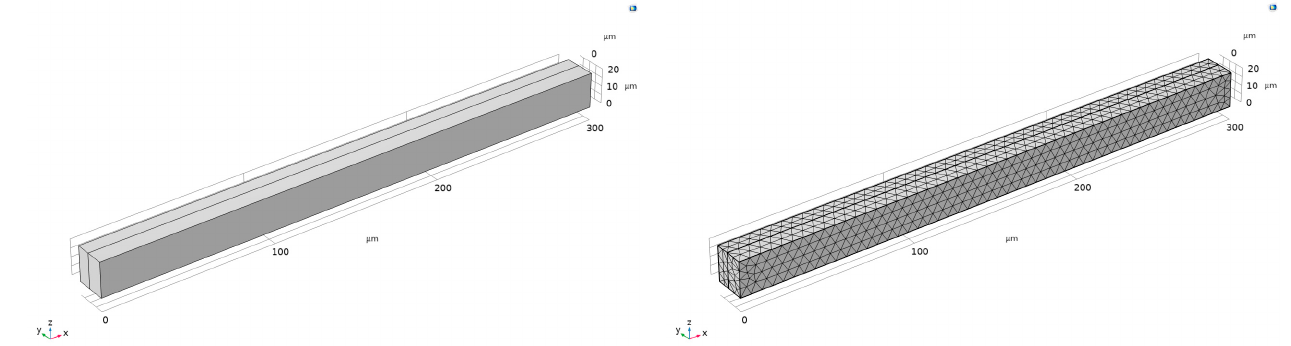
Figure 3. The base beam design geometry of the FE COMSOL model used in the simulation with a mesh sample.